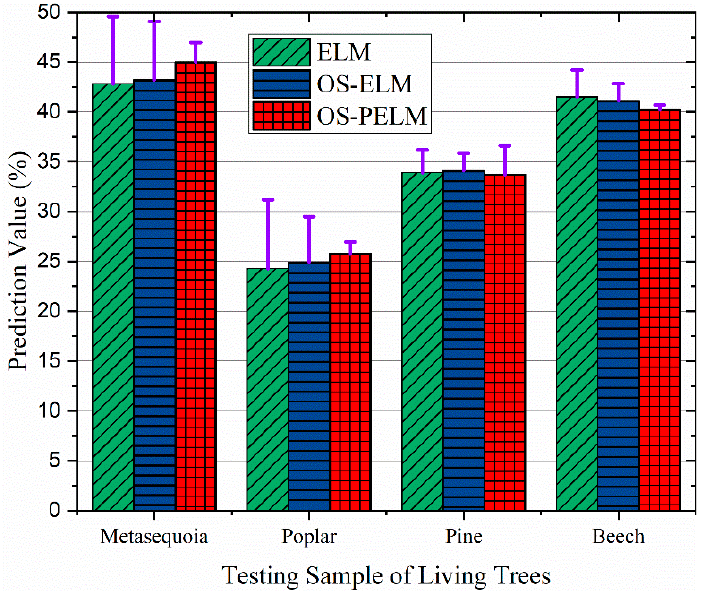
Figure 12. The prediction results of the OS-PELM algorithm and two comparison algorithms for four different kinds of living trees (metasequoia, poplar, pine and beech, with MC levels of 45.9%, 26.1%, 34.7%, and